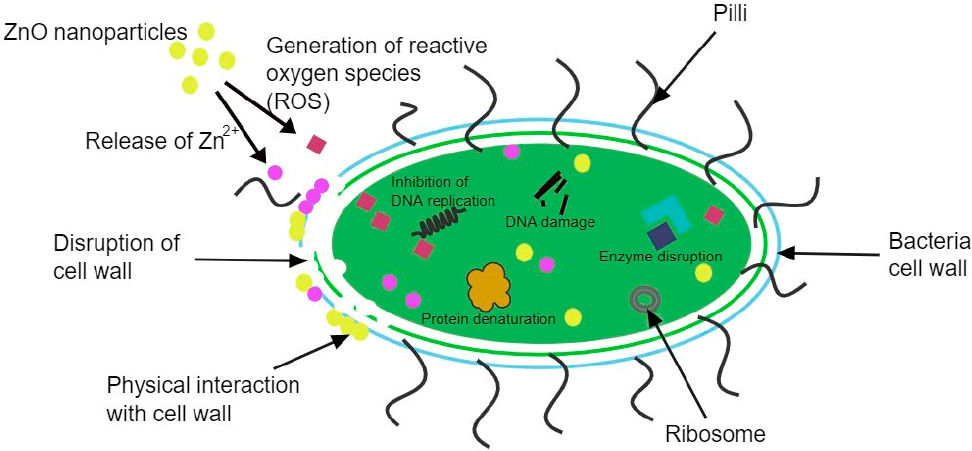
Figure 5. Mechanisms of antibacterial activity of ZnO NPs.